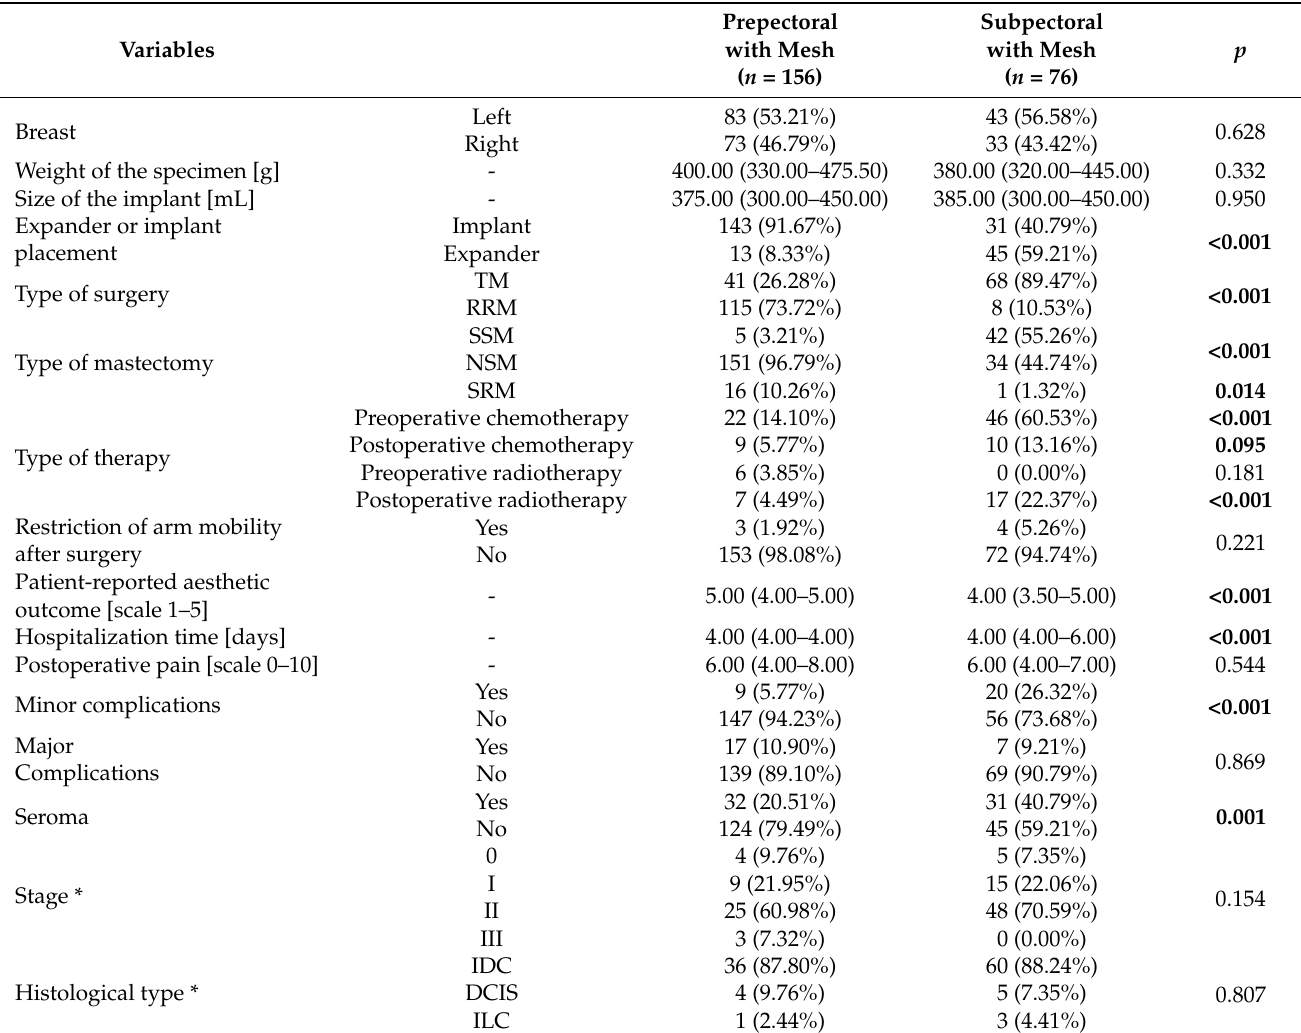
Table 2. Patient and procedure characteristics (each case in the table denotes a single surgery) in relation to the type of